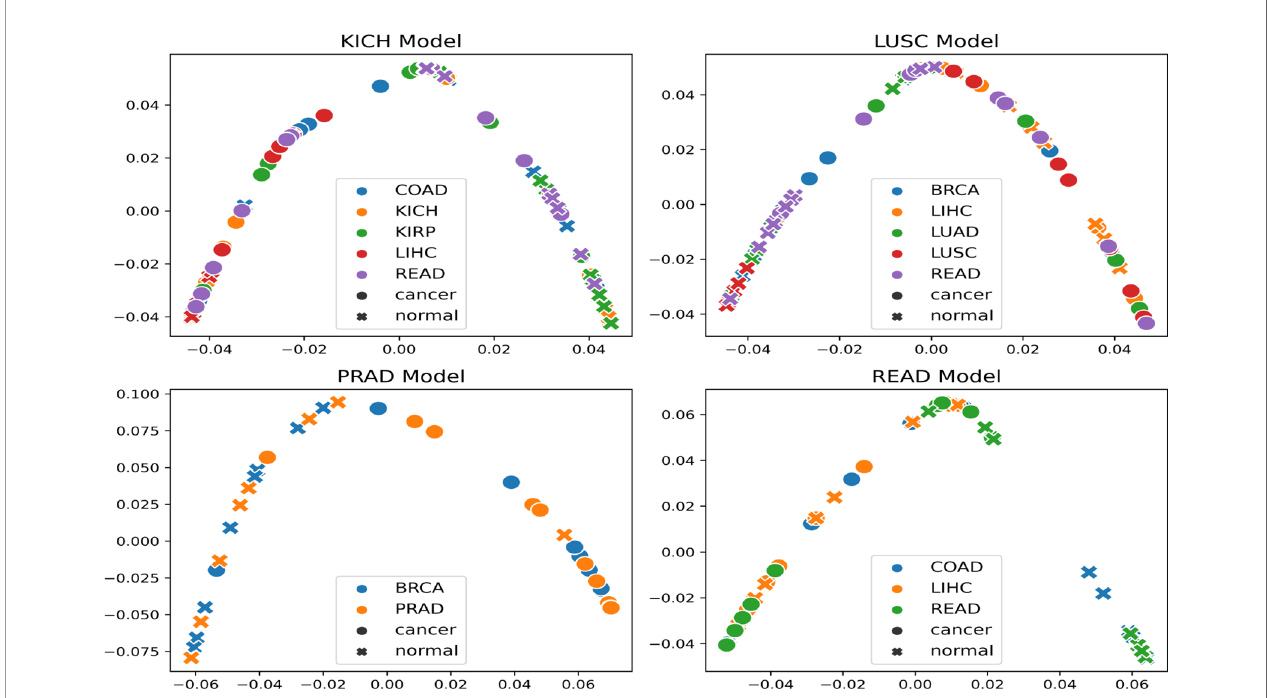
FIGURE 6 | t-SNE embeddings of the trained models (mentioned in the title of each fi gure) helping to visualize the separability of cancer and normal embeddings of organs unseen by the trained models.